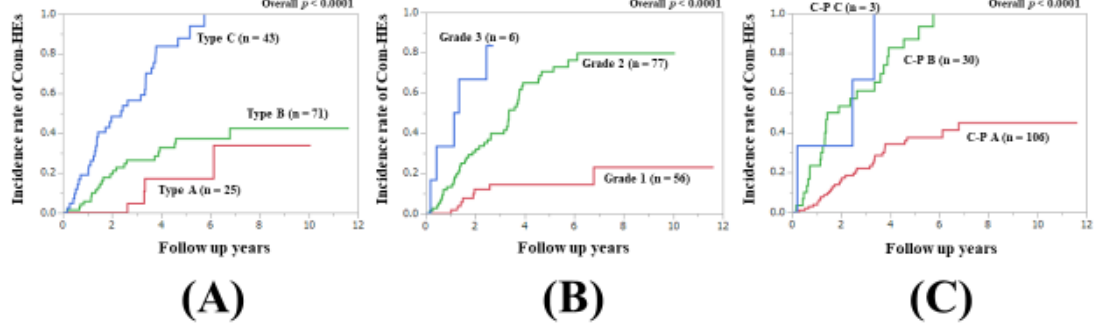
Figure 6. Cumulative incidence rates of composite hepatic events in patients with BMI >22.7 kg/m 2 (median value in our cohort, n = 139). ( A ) Serum Zn level grading system. ( B ) ALBI grading system. ( C ) Child–Pugh classification.